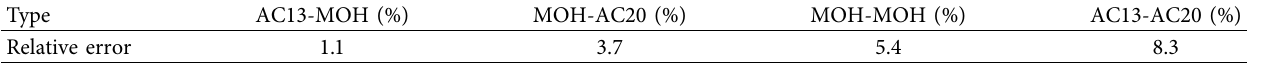
Table 5: Error between the experimental and simulation results.